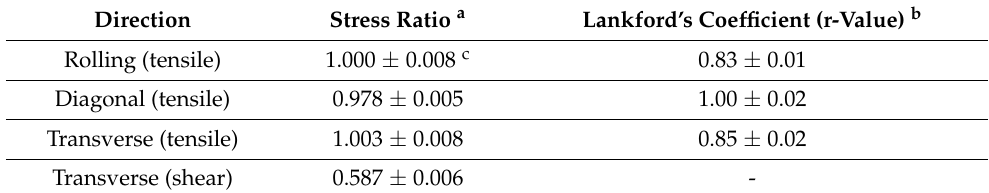
Table A1. The anisotropic properties of the 25 ◦ C die-cooled condition of Ductibor ® 1000-AS. Direction Stress Ratio a